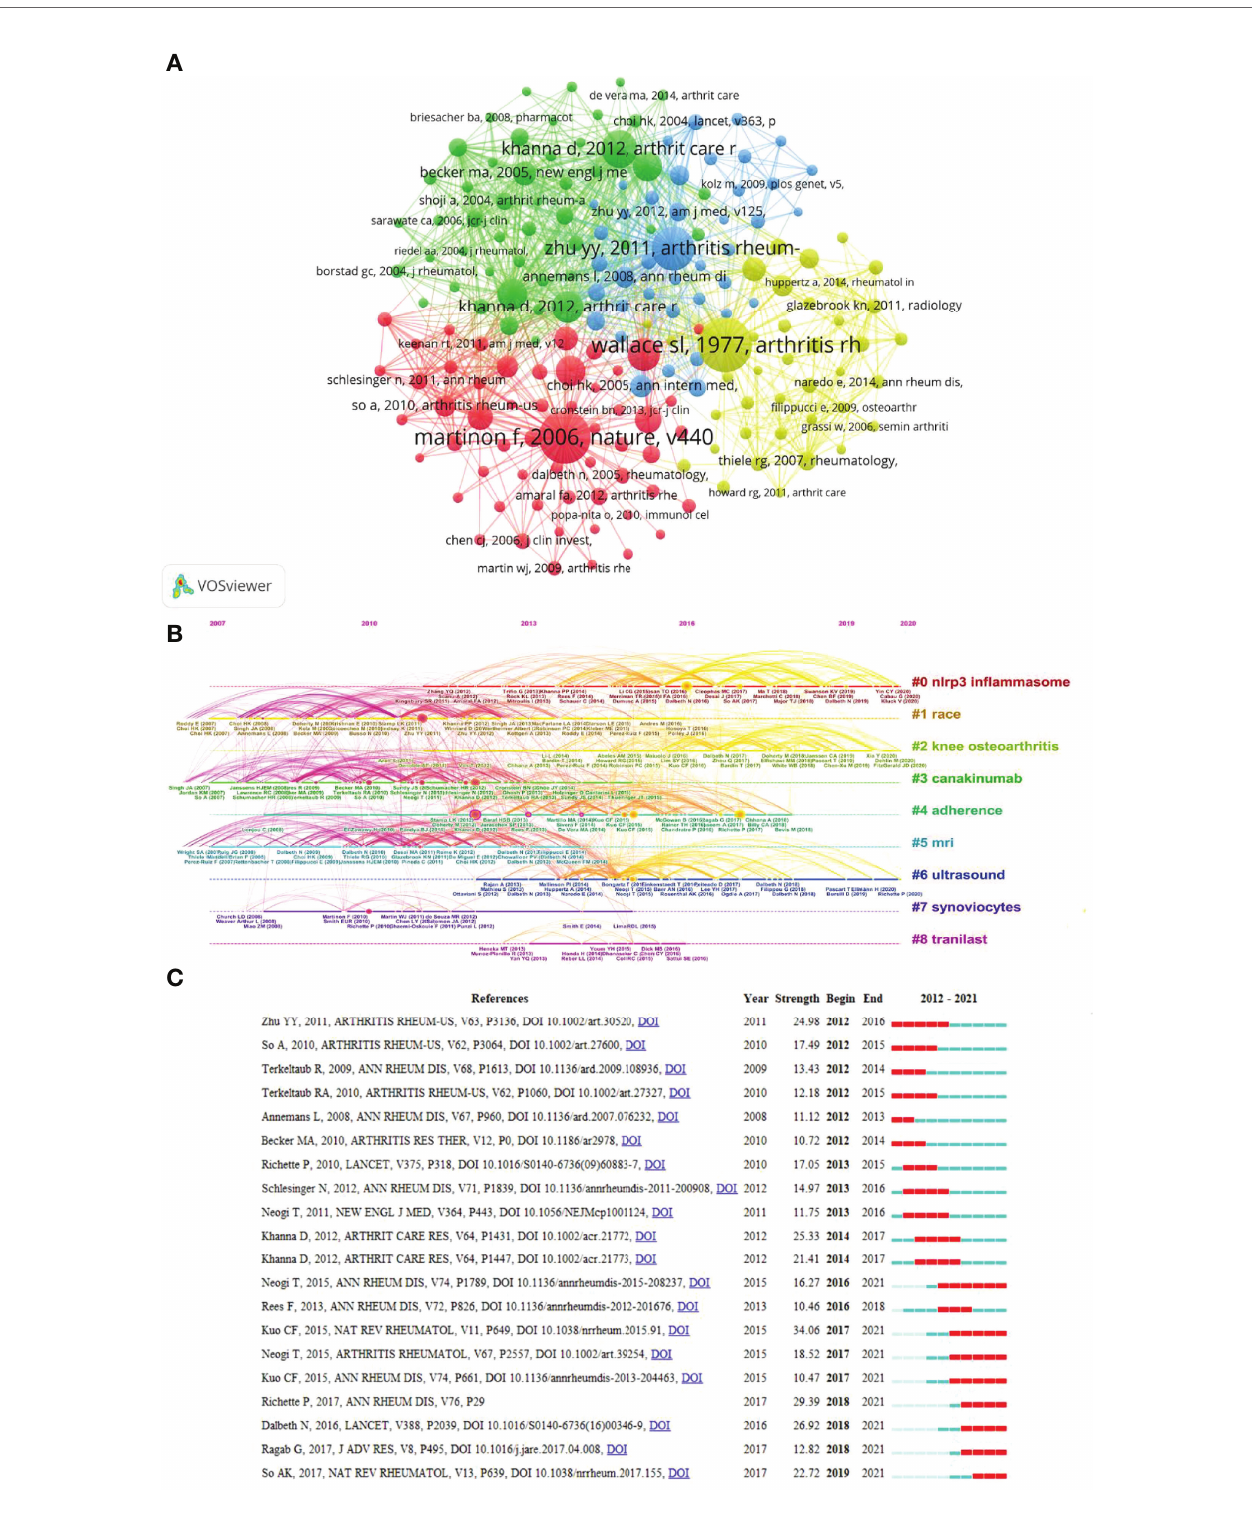
FIGURE 7 | Mapping based on co-cited references from GA-related research. (A) A network diagram of co-cited references. Of the 51775 references, 184 (divided into four clusters) were cited at least 30 times. (B) The top nine clusters ’ timeline distribution. (C) The top 20 co-cited references with the most citation burstiness. The years between “ Begin ” and “ End ” represent the period when the reference was more in fl uential. Years in light green mean that the reference has not yet appeared, years in dark green mean that the reference is less in fl uential, and years in red mean that the reference is more in fl